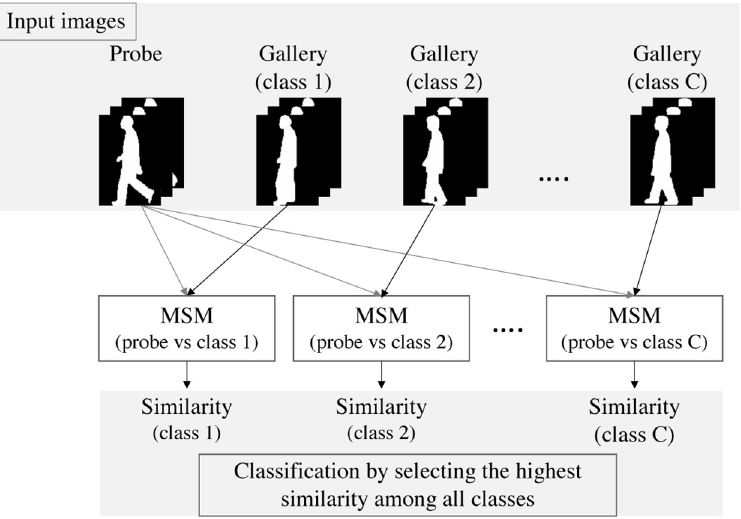
Fig 1. An overview of the gait recognition based on MSM. From gallery images of class c and input images of a probe subject, similarities between the class c and the subject are calculated based on MSM. This process is repeated for all classes in the database, and the subject is classified based on the